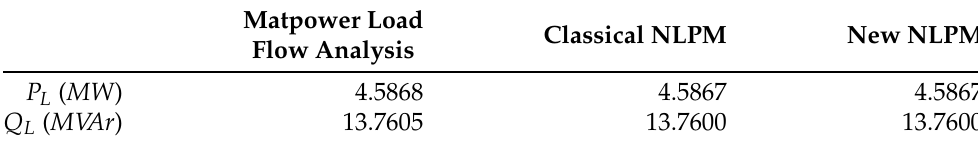
Table 2. Power loss values without bad data measurements.